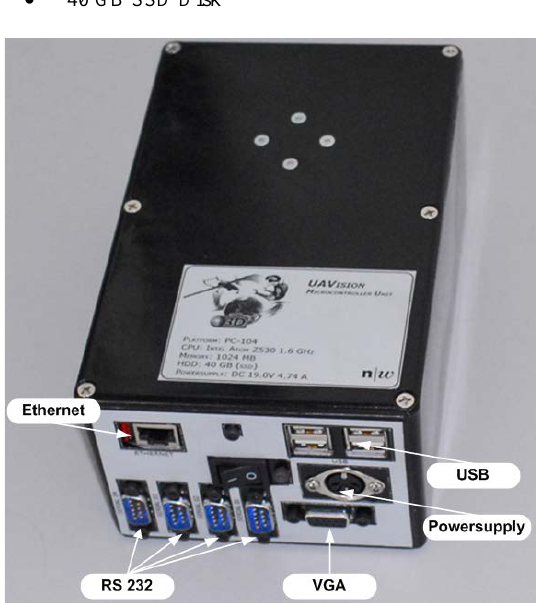
Figure 3: UAVision payload controller in custom casing